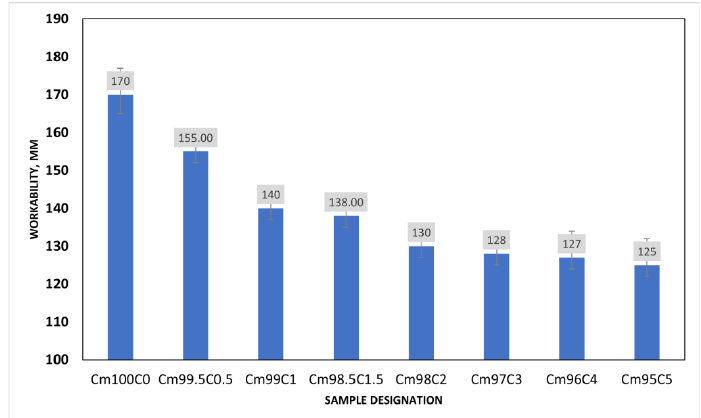
Figure 5. Workability of coffee silverskin blended mortar.